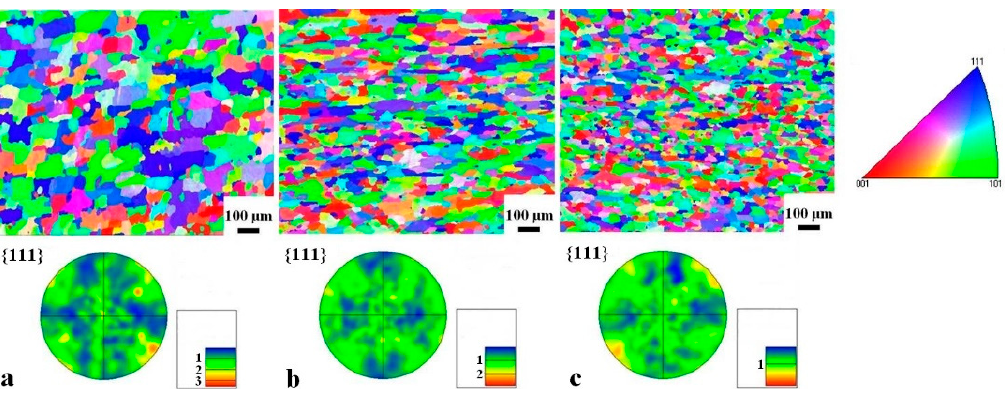
Figure 6. EBSD mapping (IPF Z) and pole figures for rolled and heat-treated samples in centre position for symmetrically rolled 1.0 ( a ), asymmetrically rolled 1.5 ( b ) and asymmetrically rolled 2.0 ( c ).